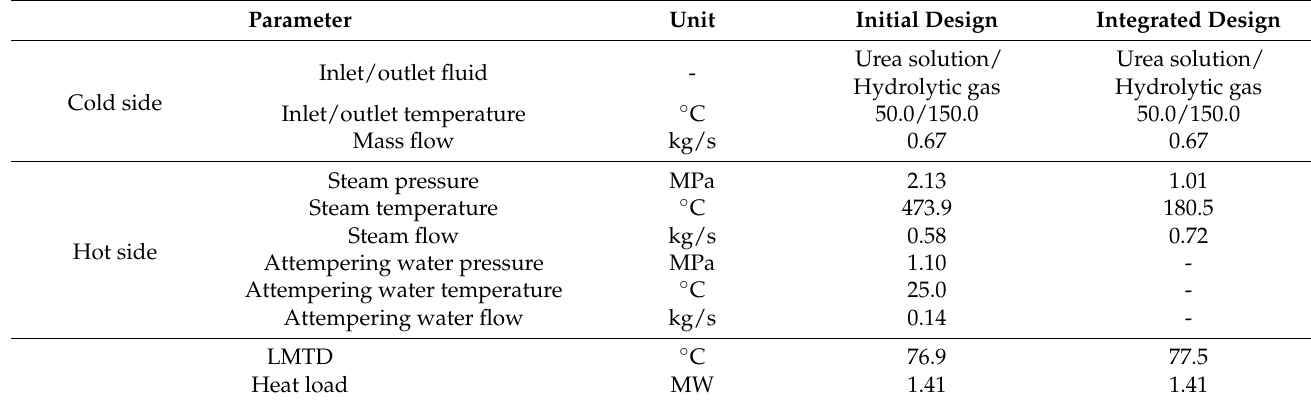
Table 11. Comparison of the UHU in the initial and integrated